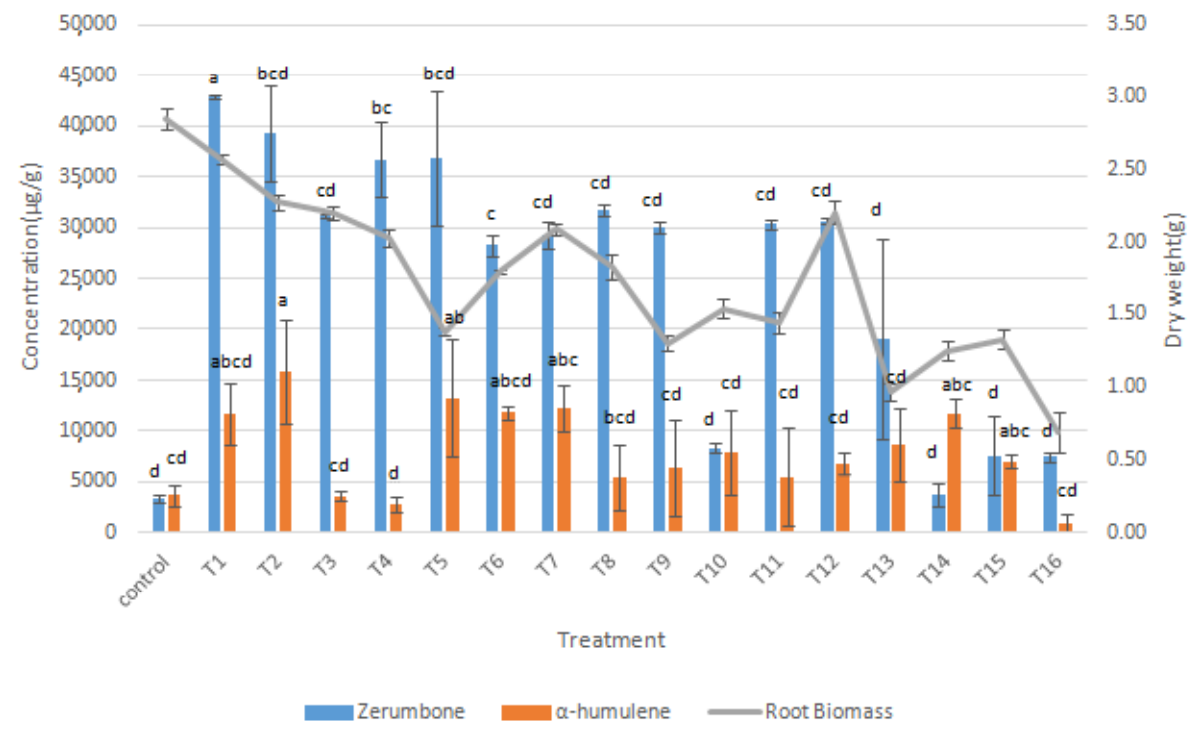
Figure 6. Synergistic effects of MeJa and SA on zerumbone, α -humulene, and root biomass of Z. zerumbet after 26 days of culture following elicitation: (T1) 400 µ M MeJa + 400 µ M SA; (T2) 400 µ M MeJa + 600 µ M SA; (T3) 400 µ M MeJa + 800 µ M SA; (T4) 400 µ M MeJa + 1200 µ M SA; (T5) 600 µ M MeJa + 400 µ M SA; (T6) 600 µ M MeJa + 600 µ M SA; (T7) 600 µ M MeJa + 800 µ M SA; (T8) 600 µ M MeJa + 1200 µ M SA; (T9) 800 µ M MeJa + 400 µ M SA; (T10) 800 µ M MeJa + 600 µ M SA; (T11) 800 µ M MeJa + 800 µ M SA; (T12) 800 µ M MeJa and 1200 µ M SA; (T13) 1200 µ M MeJa + 400 µ M SA; (T14) 1200 µ M MeJa + 600 µ M SA; (T15) 1200 µ M MeJa + 800 µ M SA; (T16) 1200 µ M MeJa + 1200 µ M SA. Error bars indicated standard deviation of the mean value. Means with different letters in the same column are significantly different at p < 0.05 according to ANOVA and Tukey’s multiple range test. While adding elicitors resulted in strong inhibition of root growth [32], the root biomass growth in the current study was not significantly inhibited at lower concentrations of combined elicitors. In addition, the amount of zerumbone was higher than that of α -humulene in all treated root cultures of Z. zerumbet (Figure 6). It is possible that the synergistic application of MeJa and SA triggered the plant defense system to produce more zerumbone than α -humulene. This was attributed to the upregulation of zerumbone synthase activity in the biosynthesis pathway during elicitation. The combined treatment of 400 µ M MeJa + 400 µ M SA yielded the highest improvement in zerumbone production (43,000 ± 0.2 µ g/g), namely a 13-fold increase compared with the control. Meanwhile, treatment with 400 µ M MeJa + 600 µ M SA yielded the highest α -humulene production (15,800 ± 5.1 µ g/g), namely a 4.3-fold increase compared with the control (Figure 6). Similarly, the synergistic effects of MeJa and SA at 0.1 mM increased the bilobalide and ginkgolide production in Ginkgo biloba cultures [33], which could be explained by the changes in its metabolomics